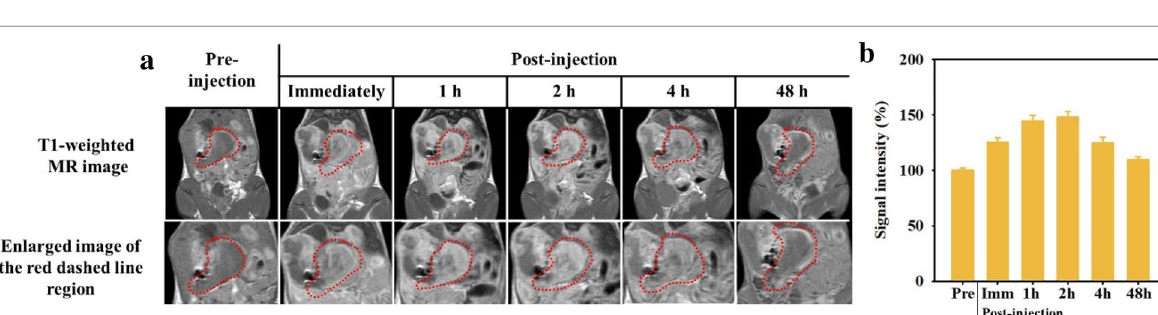
Fig. 7 a T1‑weighted MR images and relative signal intensity graphs of SNU‑484 cells incubated with MnOExHo (ΔR1 treatment), b TEM images of SNU‑484 cells treated with MnOExHo (scale bar: 500 nm, inset scale bar: 2 μm)